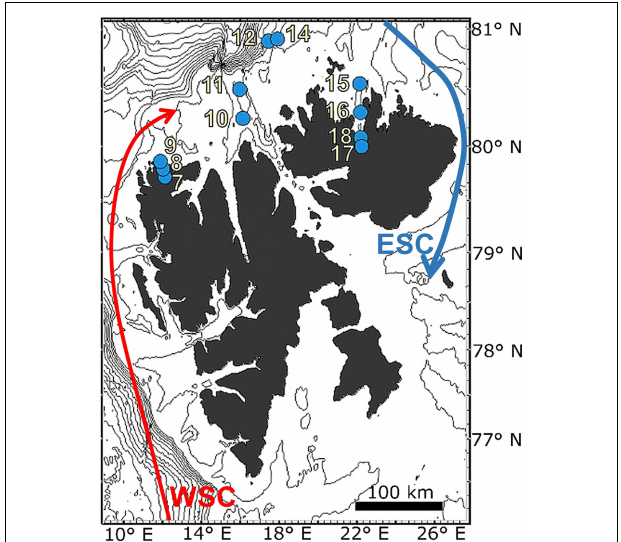
FIGURE 1 | Map of sampling stations in north Svalbard. Depth contours are shown every 150m. WSC, West Spitsbergen Current (Atlantic Water); ESC, East Spitsbergen Current (Arctic